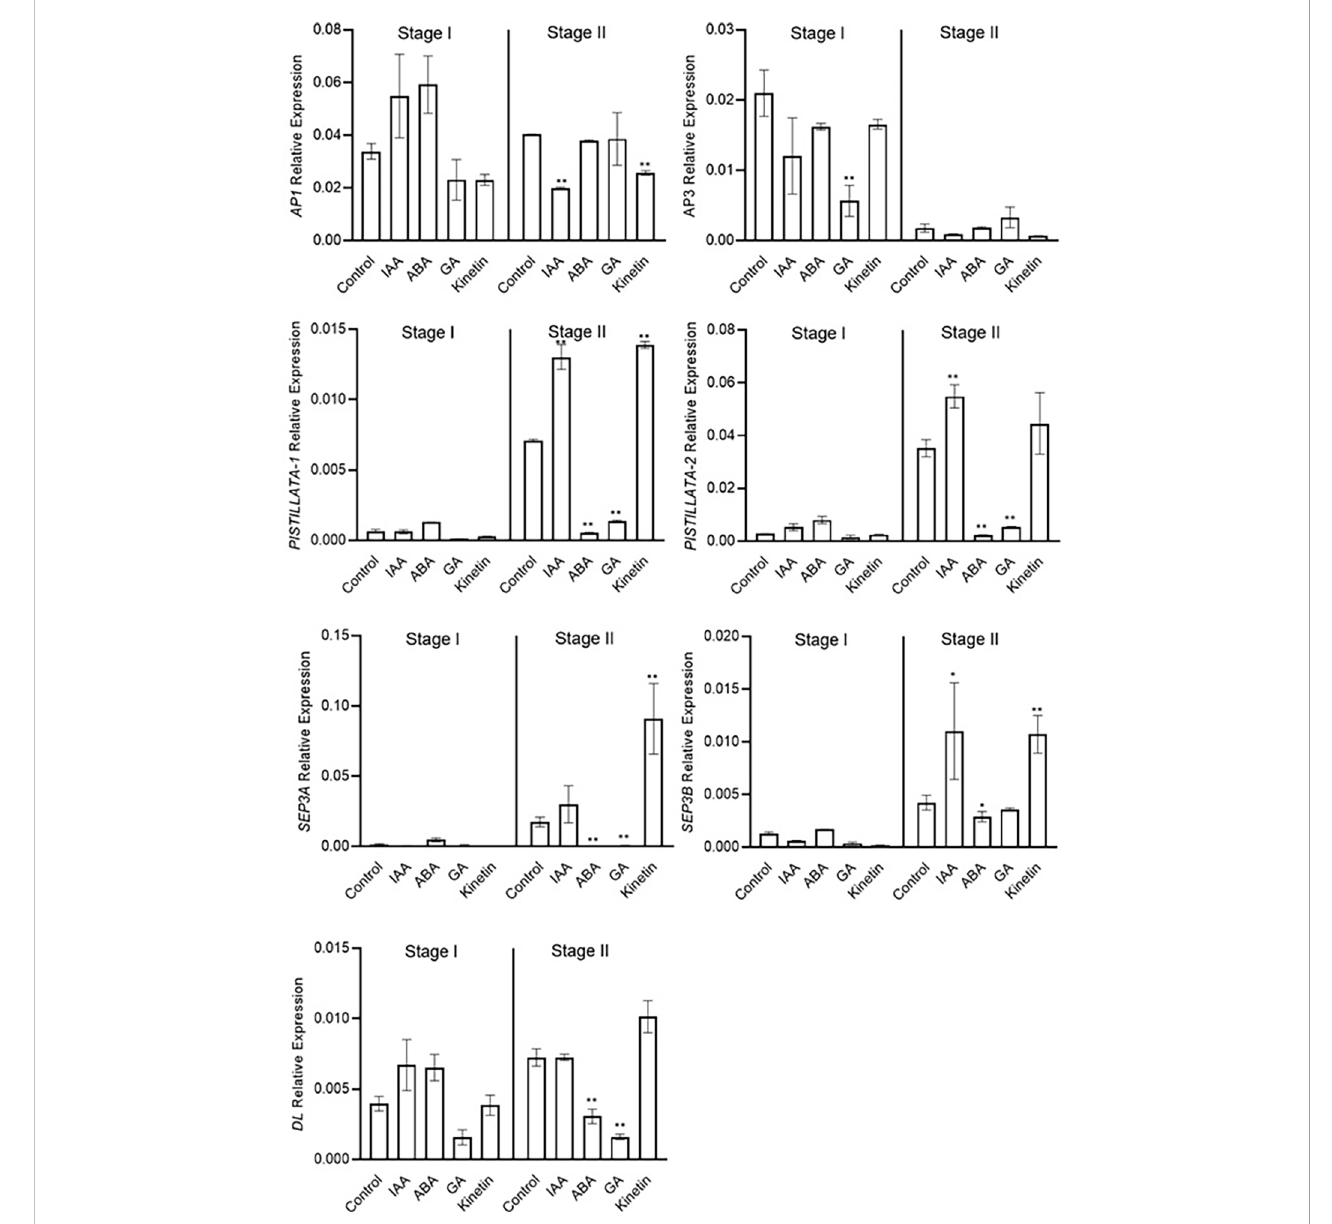
FIGURE 5 Expression pro fi ling of genes involved in fl ower formation quanti fi ed by real-time PCR in response to different hormones. Total RNA was isolated from the apical bud of corms treated with different hormones at 45 days (stage I) and 90 days (stage II) of treatments. Reactions from three separate pools of root RNA samples were run in triplicates with tubulin as the internal control for normalization. Error bars represent ± SD of three biological replicates. Stage I morphologically represents the fl ower induction stage, and stage II represents the stamen and stigma formation stage. Data represented is mean of three biological replicates. Error bars represent standard error (SE), * indicates P <0.05, ** indicates P < 0.01, with respect to control (Student ’ s